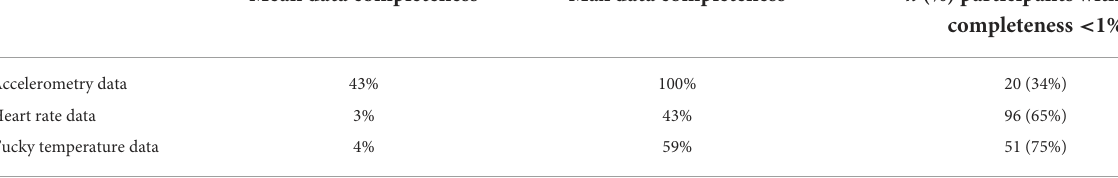
TABLE 5 Data completeness of the variables: accelerometry, heart rate, and body shell temperature for all study participants for the complete 9-week study period.